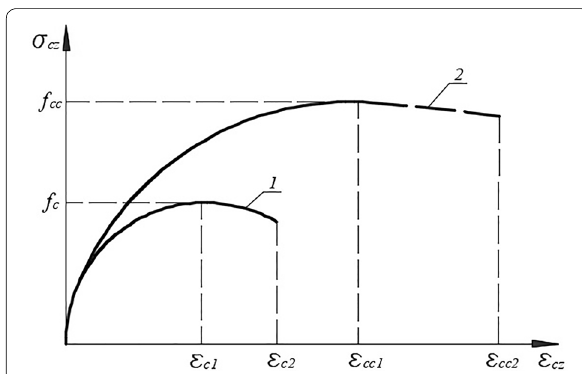
Fig. 1 Diagrams of concrete deformation under uniaxial compression (1) and with triaxial compression